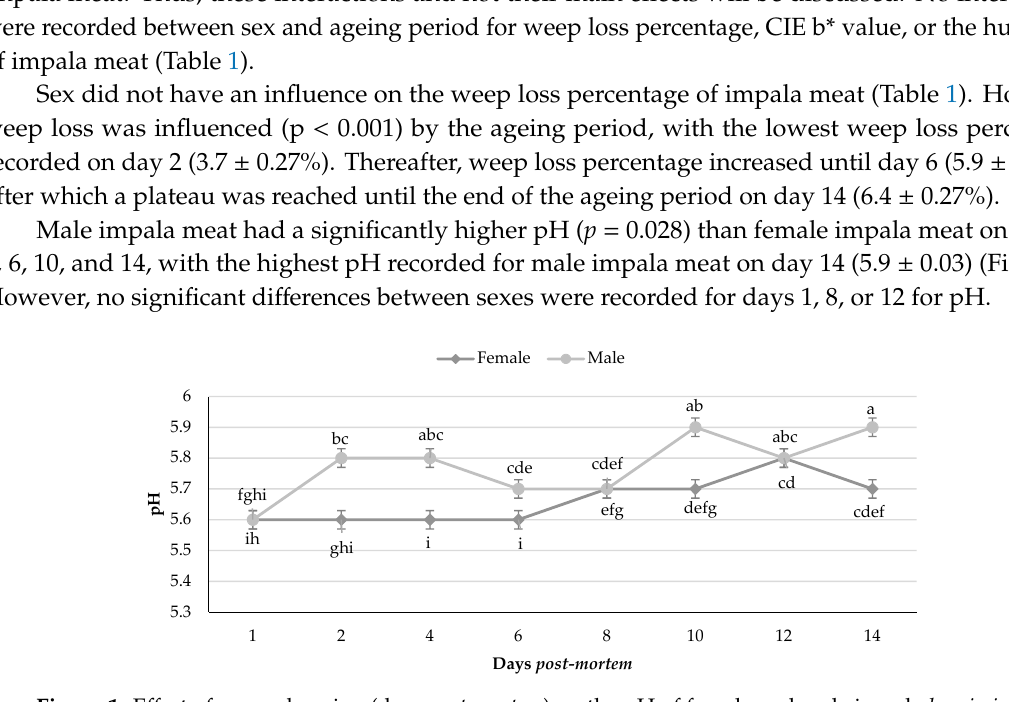
Figure 1. Effect of sex and ageing (days post-mortem ) on the pH of female and male impala longissimus thoracis et lumborum muscles. a–i Means with different superscripts differ from one another ( p ≤ 0.05). Error bars represent the standard error of the means.